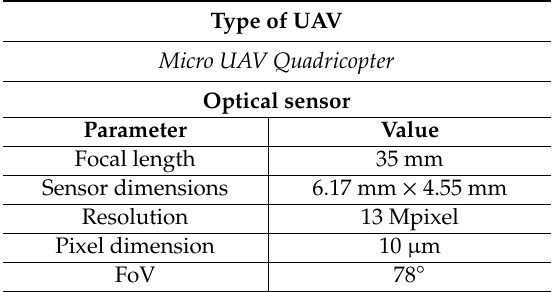
Table 1. Technical specifications of the UAV used for the